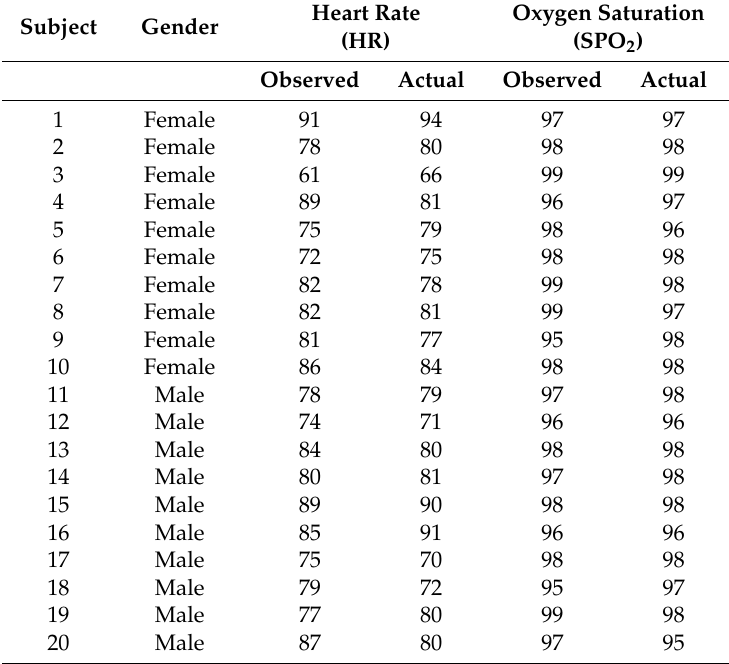
Table 5. Experimental values measured for 20 human subjects using developed stretchable oximeter.